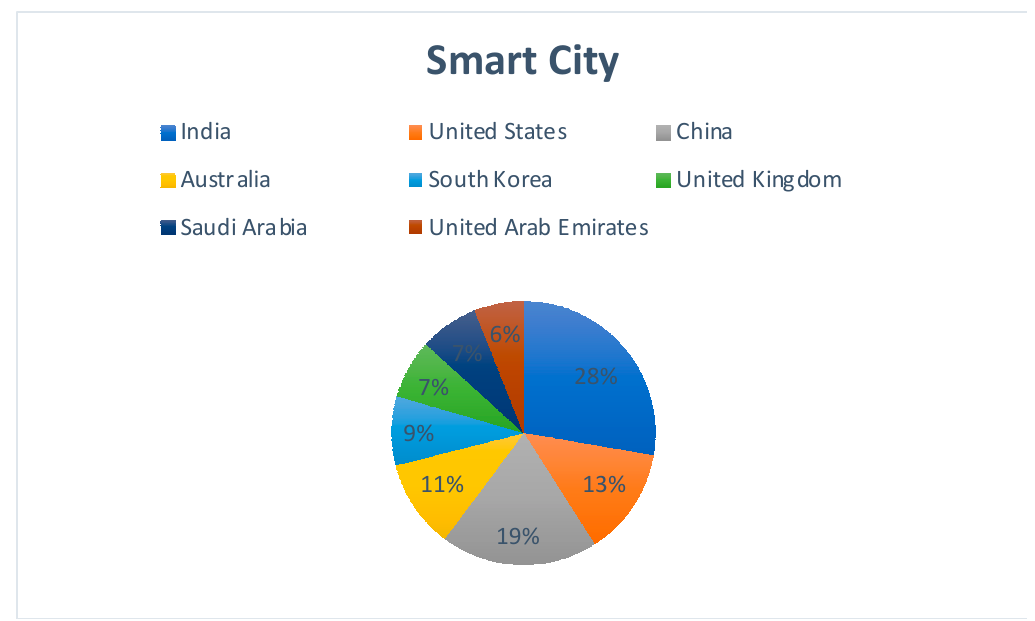
Figure 8. Region-specific publication distribution for Blockchain–Cloud and Smart Cities.